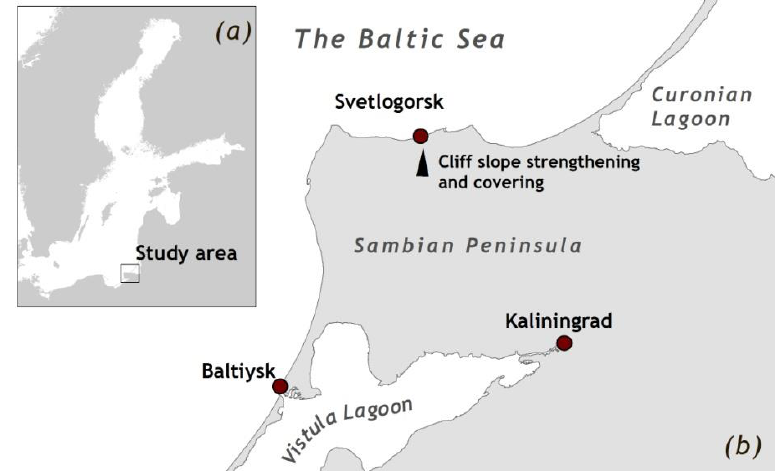
Figure 1. The coastal landslide protection construction, the biggest in the Baltic Sea region ( a ), is located in the City of Svetlogorsk (Kaliningrad Oblast, Russia) at the northern shore of the Sambian Peninsula ( b ).